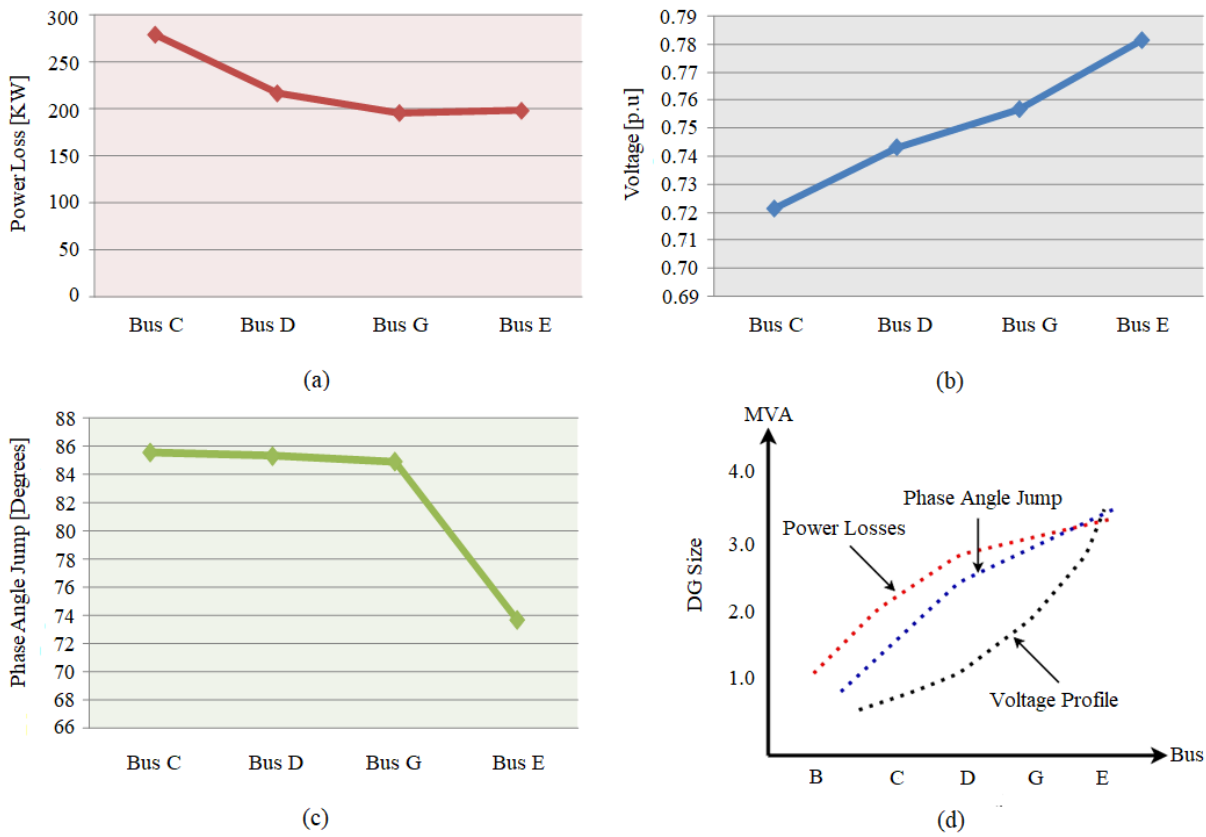
Figure 8. System performance under fault condition for the optimal location and size of the new DG: ( a ) power losses at different system buses, ( b ) system voltage profile, ( c ) the trend of PAJ at various buses, and ( d ) GA output over 32